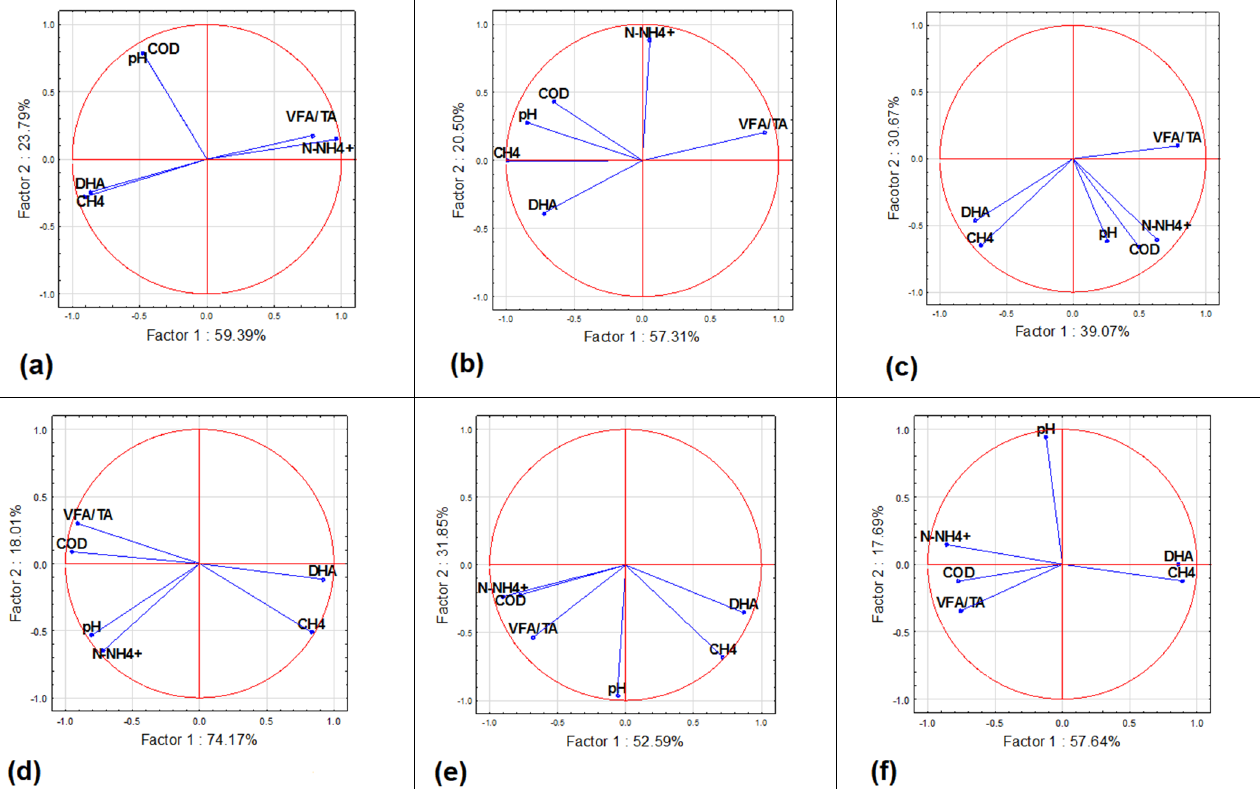
Figure 11. Distribution of dehydrogenase activity as well as chemical properties in the tested samples: ( a ) WF—control; ( b ) WF + PLAG; ( c ) WF + PLAP; ( d ) WFC—control; ( e ) WFC + PLAG; ( f ) WFC + PLAP, in two PCA axes. Legend: DHA—dehydrogenase activity, VFA/TA ratio—volatile fatty acids-to-total alkalinity ratio, N-NH 4+ —ammonium nitrate, COD—chemical oxygen demand.